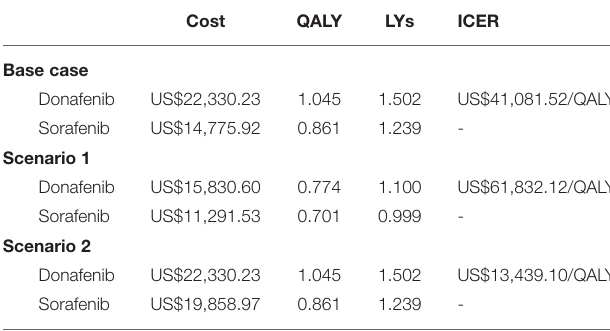
TABLE 2 | Base-case and scenario analysis